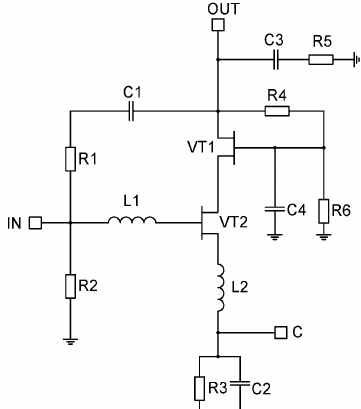
Fig. 1. Simplified circuit of the proposed amplifier.